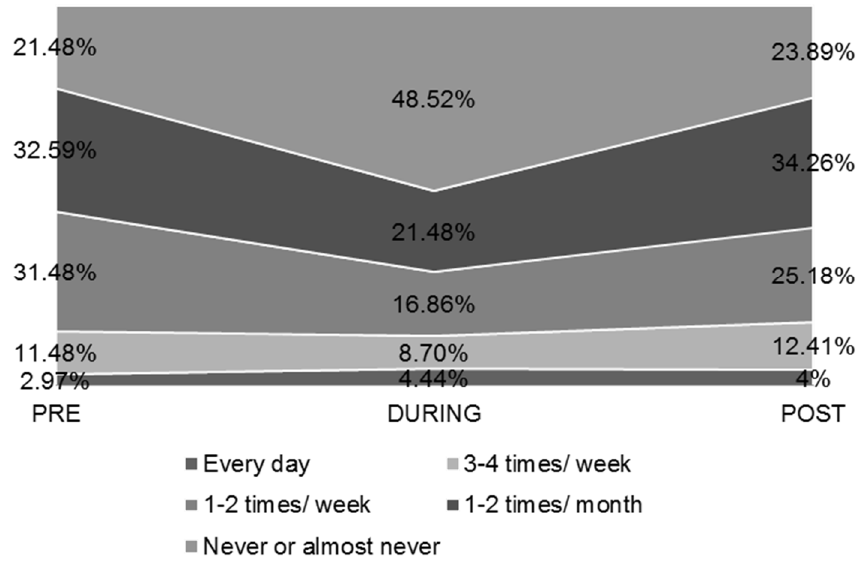
Figure 6. Frequency of alcohol consumption.